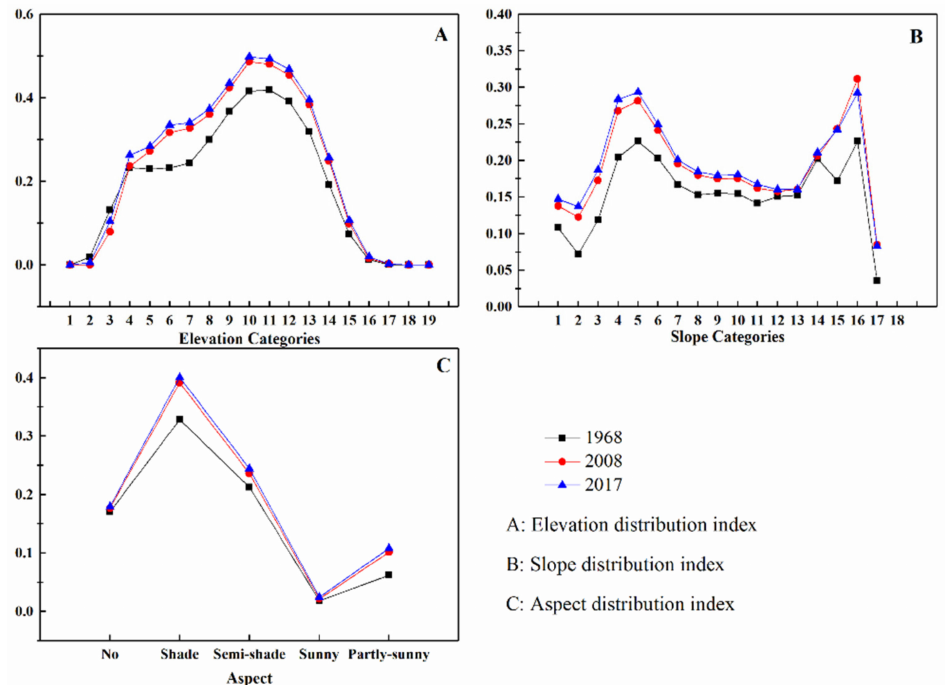
Figure 7. Change in the ( A ) elevation, ( B ) slope, and ( C ) aspect distribution index ( y -axis is the value calculated with Equation (1), and x -axis is the levels of elevation, slope, and